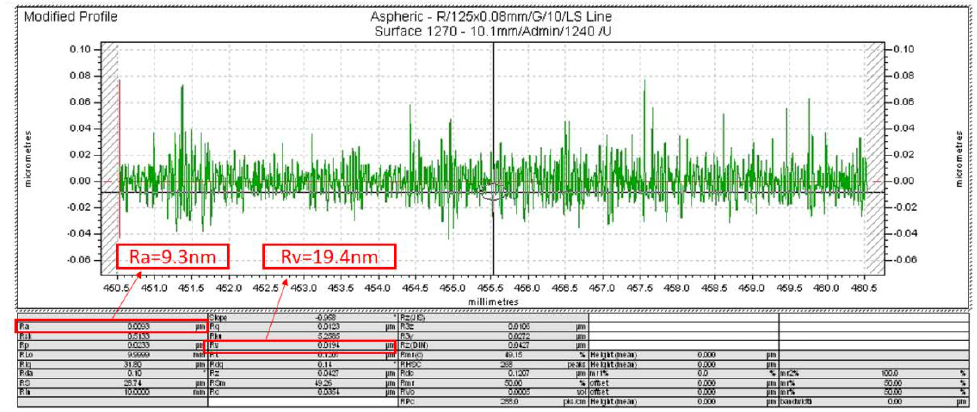
Figure 14. Result of the surface quality.